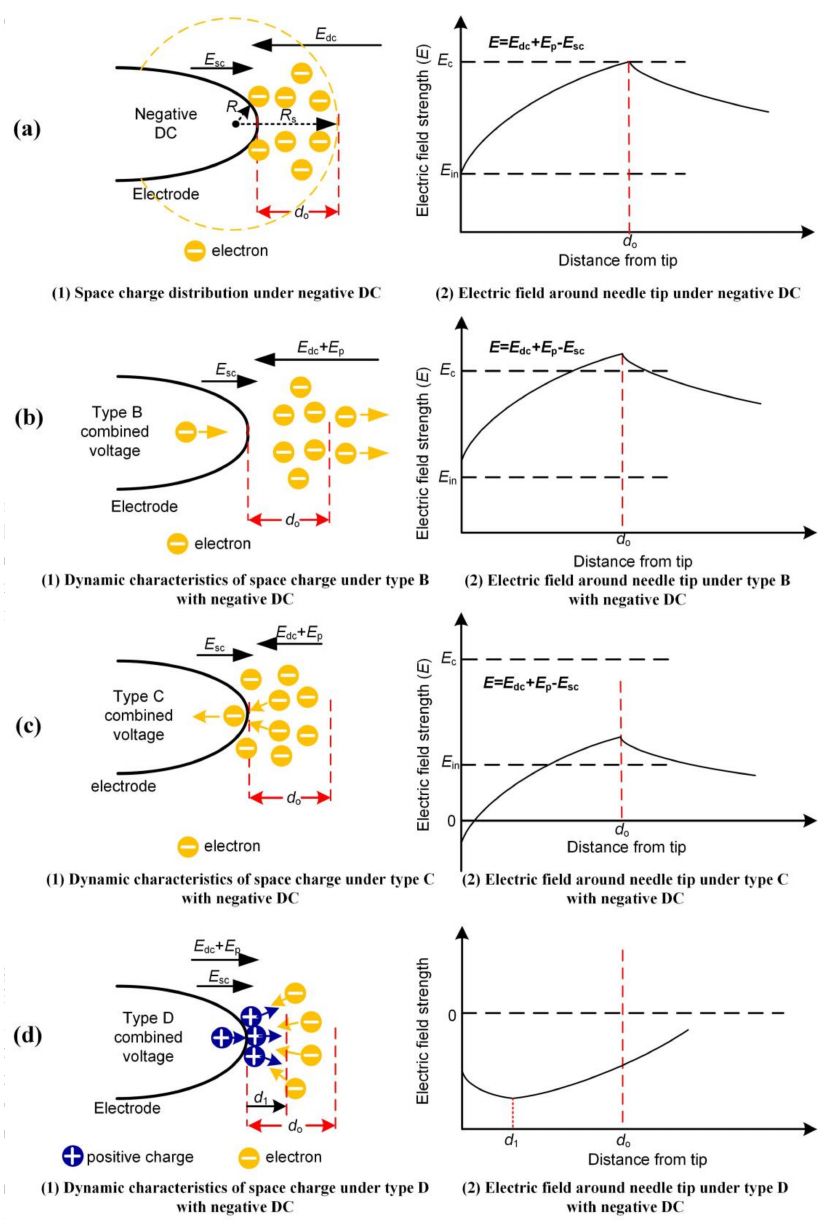
Figure 10. ( a – d ) Dynamic characteristics of space charge and electric field under negative DC and combined voltage of types B–D with negative DC,